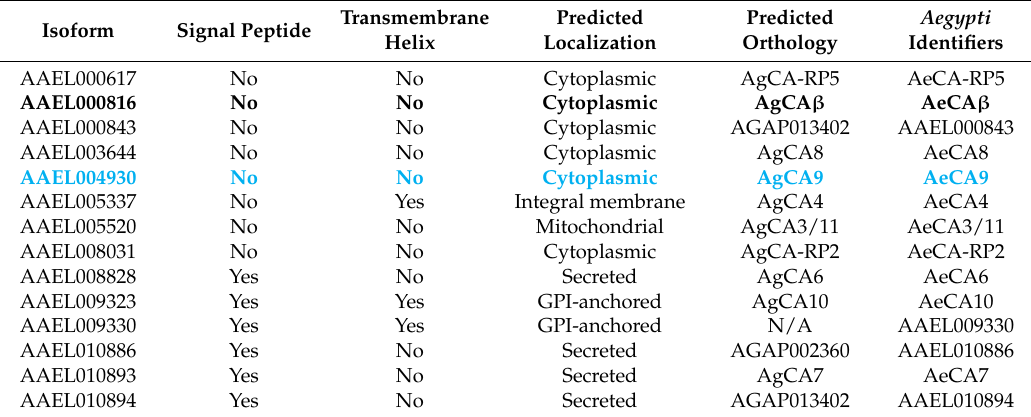
Table 2. Carbonic anhydrase proteins in Aedes aegypti